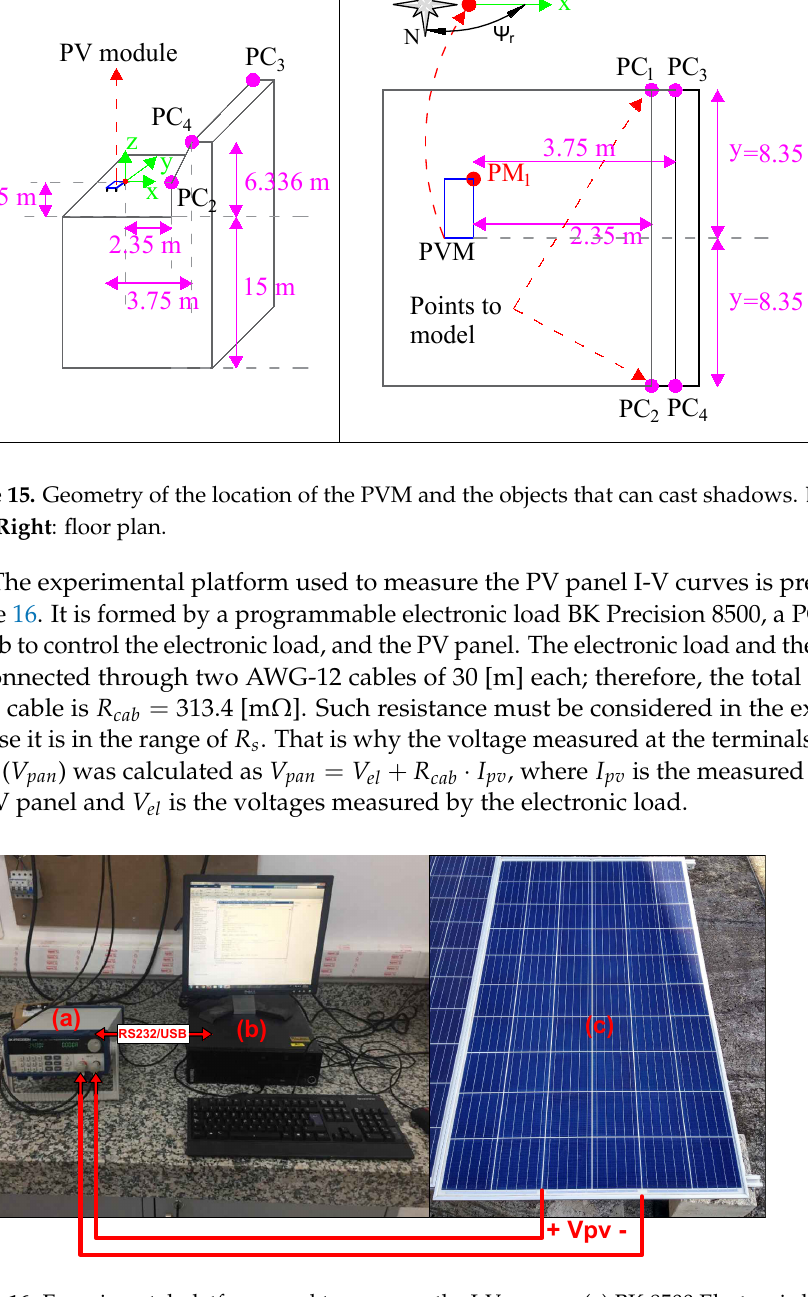
Figure 16. Experimental platform used to measure the I-V curves: ( a ) BK 8500 Electronic load, ( b ) PC with Matlab to acquire and process the data, ( c ) PV